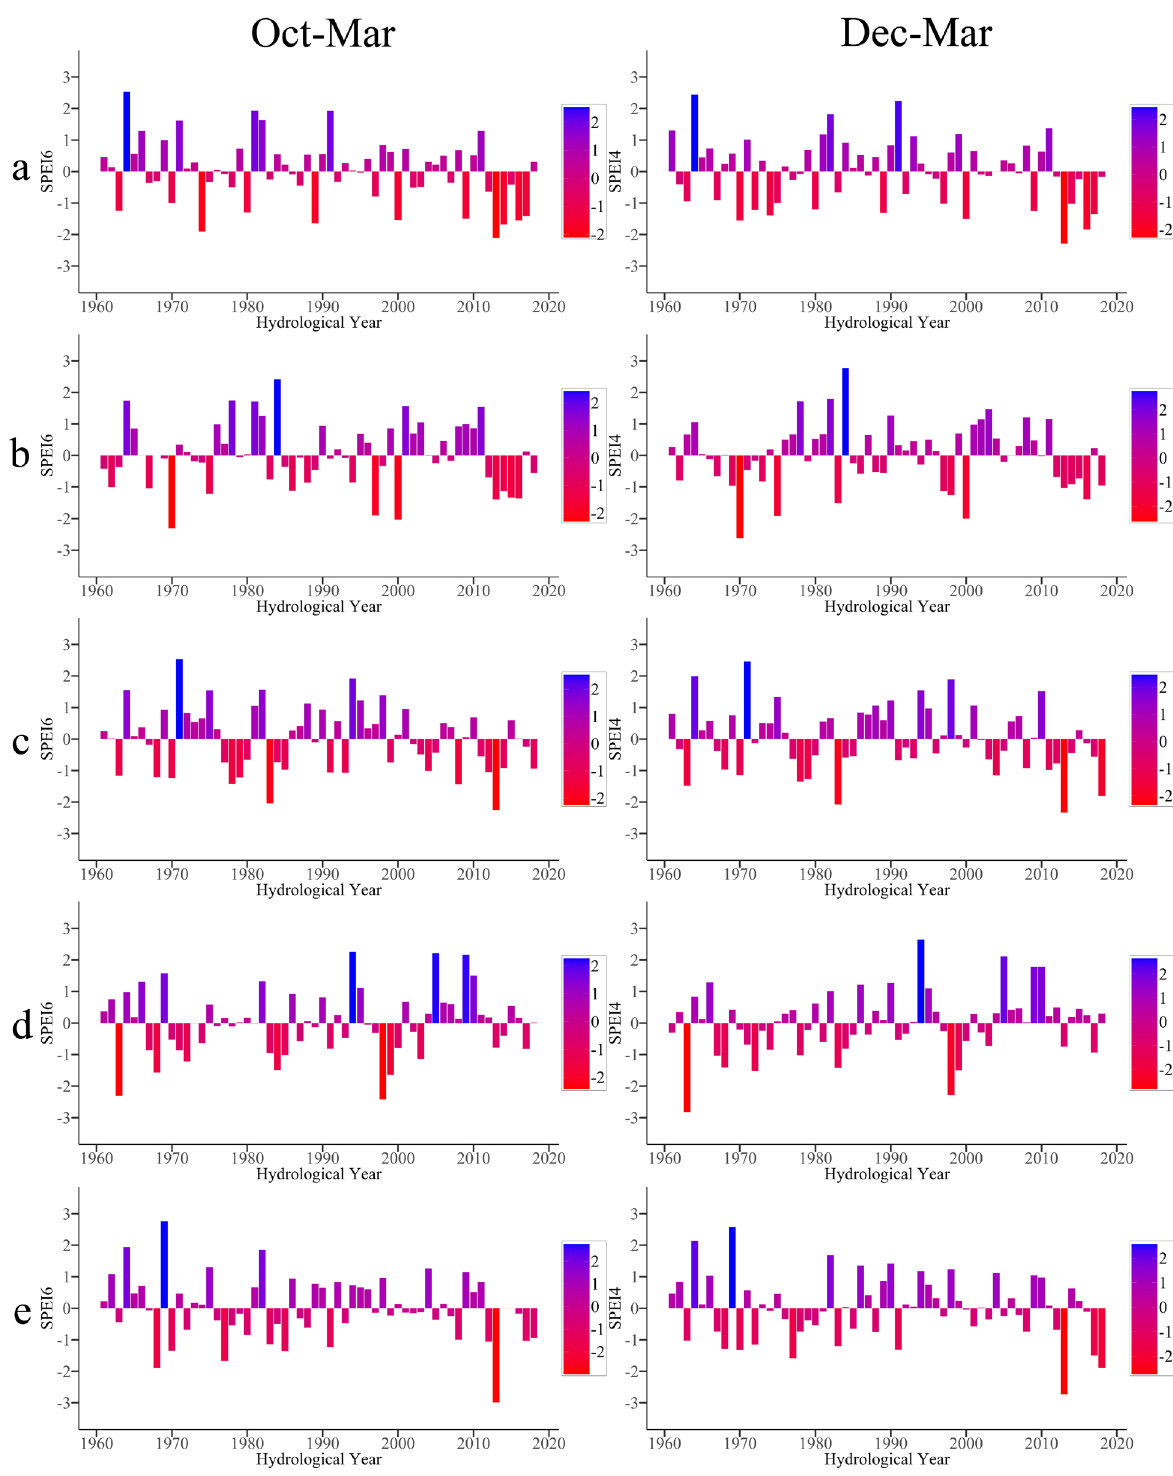
Figure 5. Temporal variability of the SPEI6 and SPEI4 for the studied locations of southeastern Brazil (a. south-MG; b. MR-BH; c. ME-SP; d. SP-city; e.